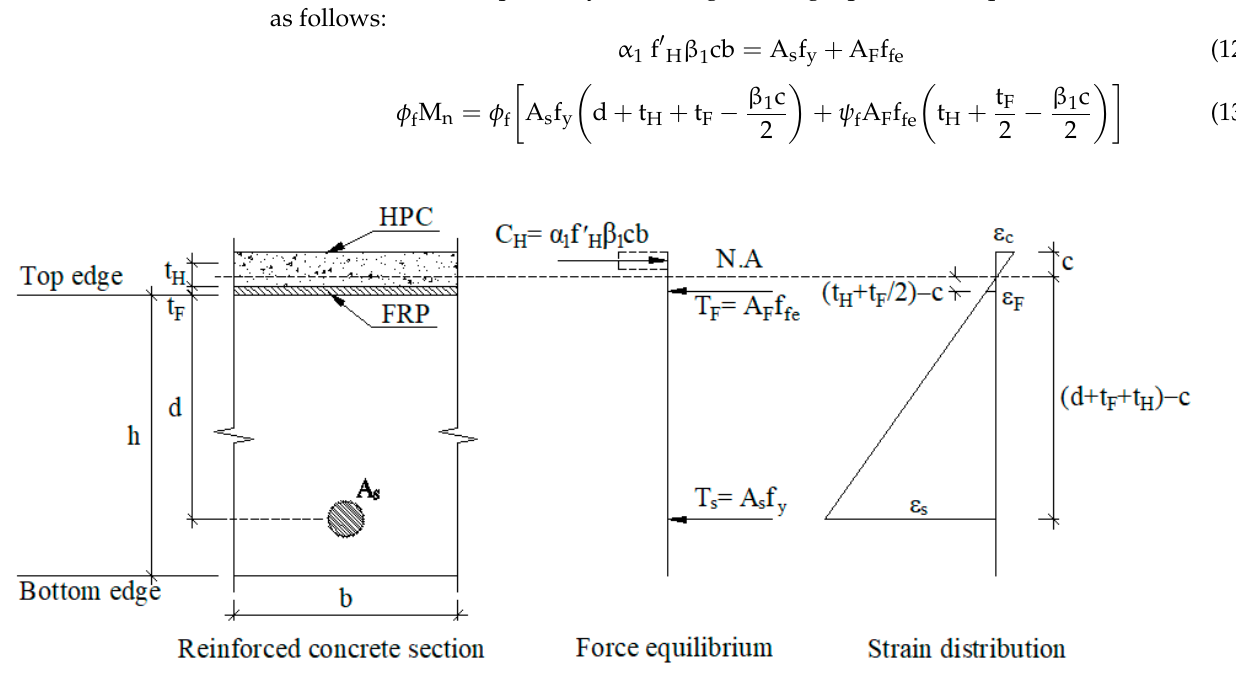
Figure 6. Retrofitting mechanism for positive moment sections (refer to section “M-M” of Figure 1).